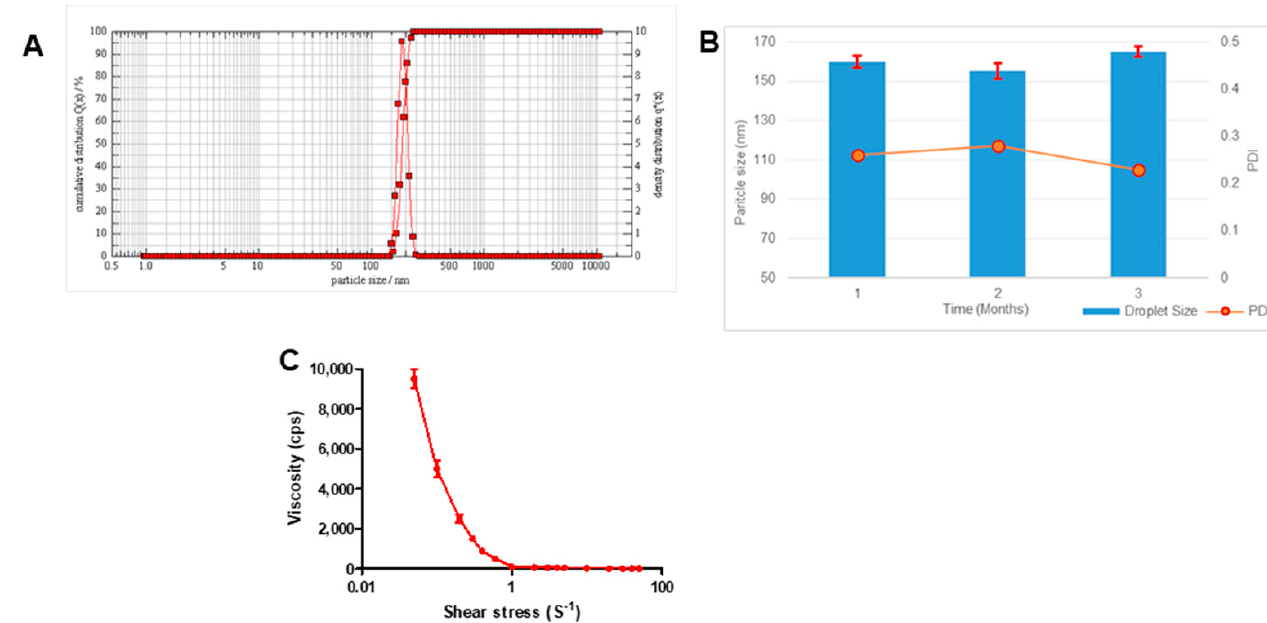
Figure 4. Characterization of chrysin-loaded nanoemulgel. ( A ) Representative graph showing droplet size, ( B ) bar graph showing droplet size and line graph showing PDI over a period of 3 months, and ( C ) viscosity versus shear stress profile.